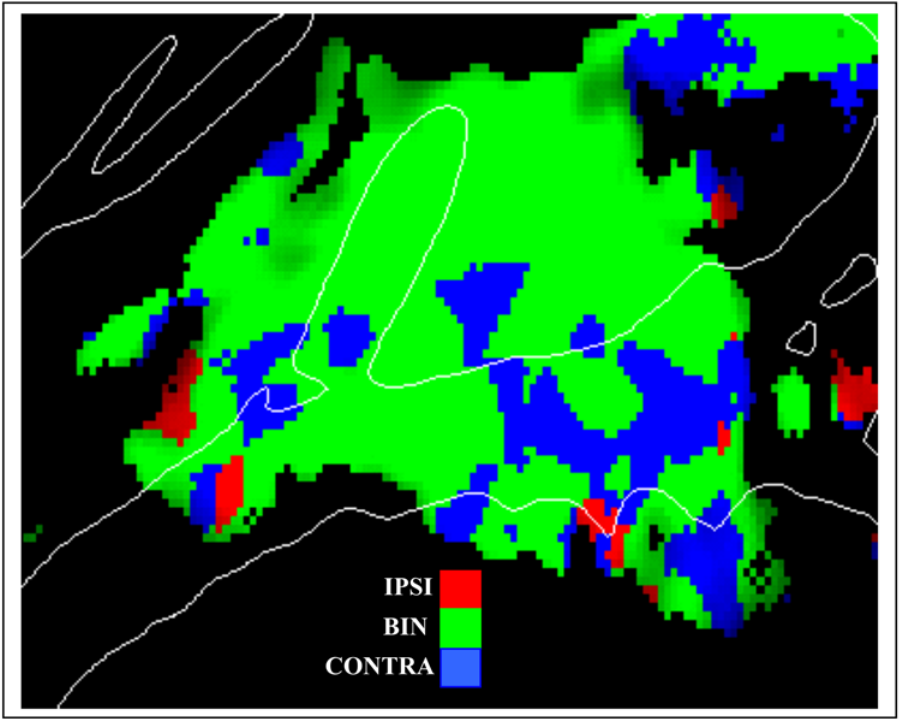
Figure 9. Effects of Ear of Delivery. Significant activations with the color showing the tone location producing maximal activation at that point on the cortical surface. Red=ipsilateral ear, green=binaural, blue=contralateral ear. Averaged over subjects, attention, image acquisition, frequencies and hemispheres. z-score threshold=4.0.